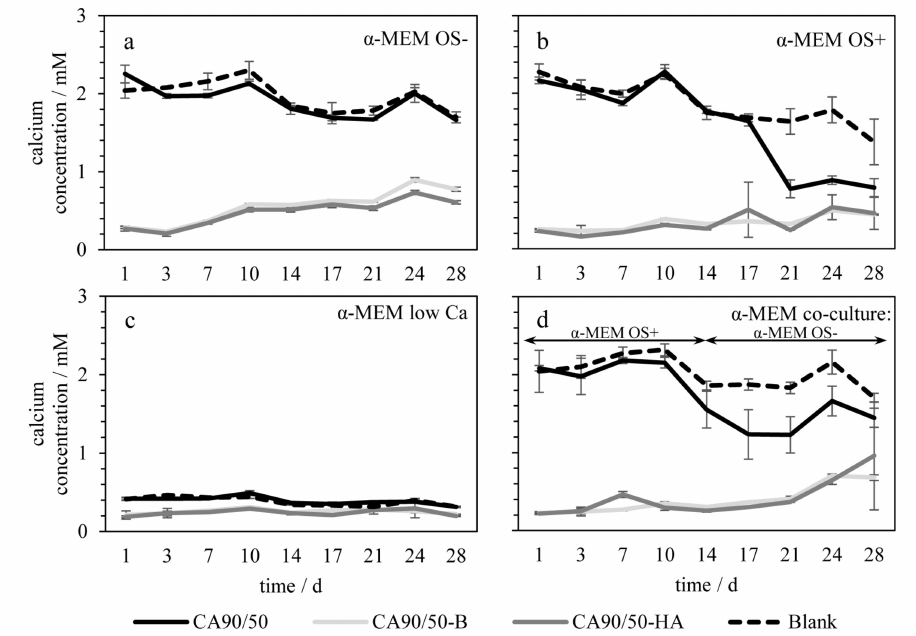
Figure 1. Calcium concentration in the cell culture media during incubation of sca ff olds without cells: ( a ) without osteogenic supplements, ( b ) with osteogenic supplements, ( c ) with low initial calcium concentration, and ( d ) with co-culture supplemented regime. Incubation of pure and calcium-phosphate-modified chitosan sca ff olds was